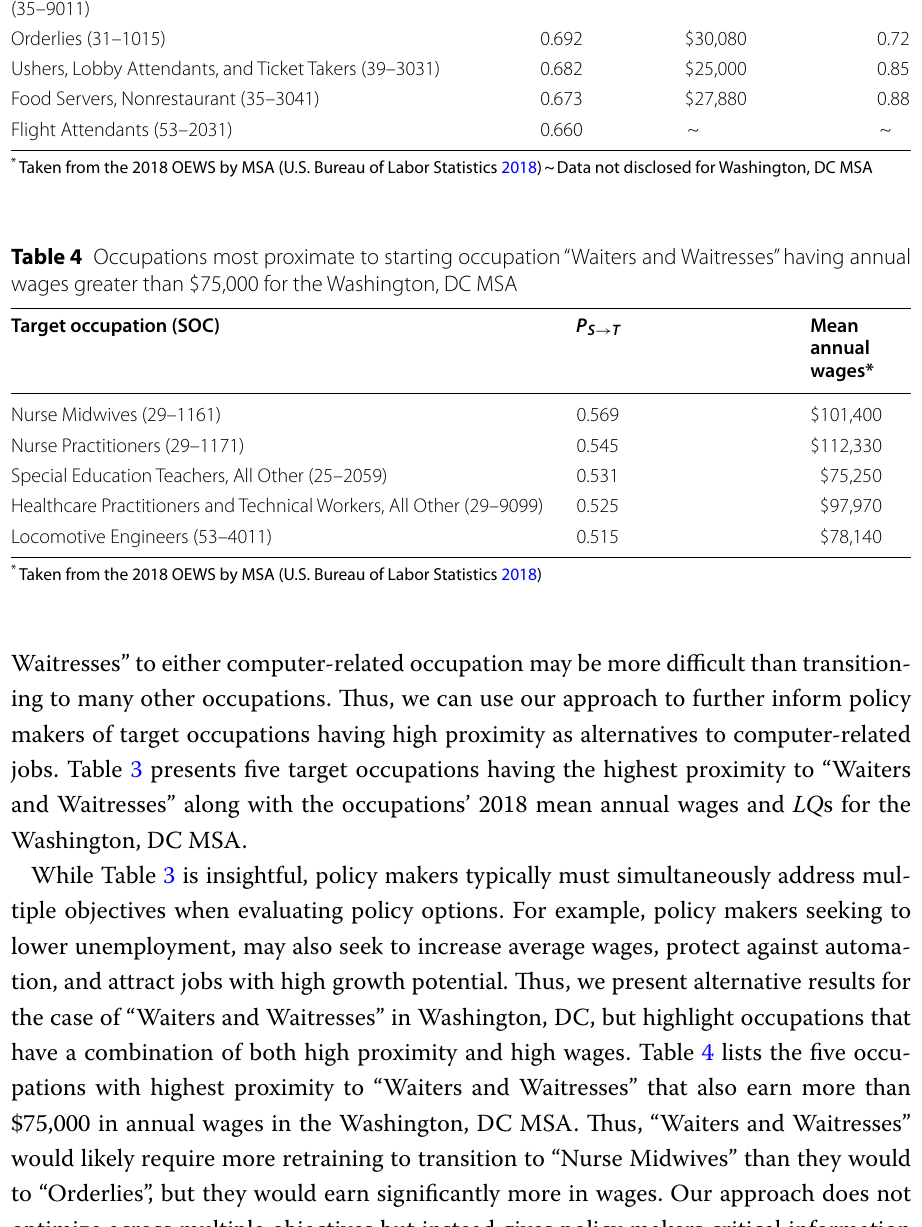
Table 3 Occupations most proximate to starting occupation “Waiters and Waitresses”, with mean annual wages and LQ values for the Washington, DC MSA Target Occupation (SOC)